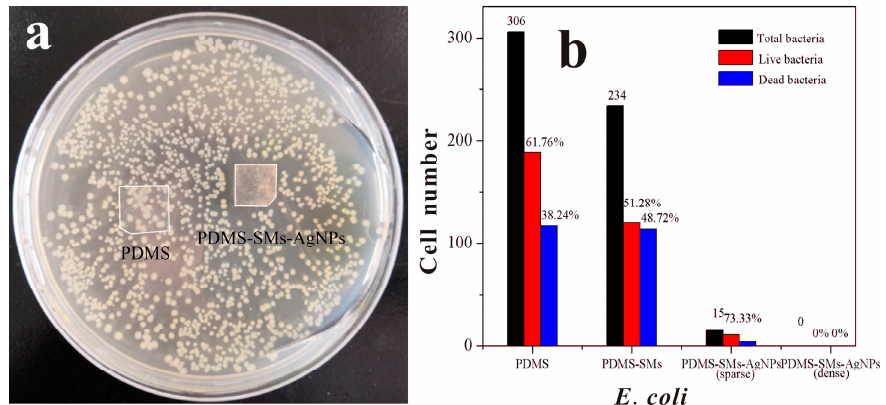
Figure 4. ZOI assay of PDMS and PDMS-SMs-AgNPs by E.coli after 24h incubation at 37 ◦ C ( a ). Cell Figure 4 . ZOI assay of PDMS and PDMS-SMs-AgNPs by E.coli after 24 h incubation at 37 °C ( a ). Cell numbers of E. coli growing on the PDMS, PDMS-SMs, sparse / tight SMs-AgNPs modified PDMS ( b ). numbers of E. coli growing on the PDMS, PDMS-SMs, sparse/tight SMs-AgNPs modified PDMS ( b ). There was no E. coli observed on the tight PDMS-SMs-AgNPs. There was no E. coli observed on the tight PDMS-SMs-AgNPs. Table 1. Zone of inhibition (ZOI) of silver nanomaterials against E. coli and B. subtilis.